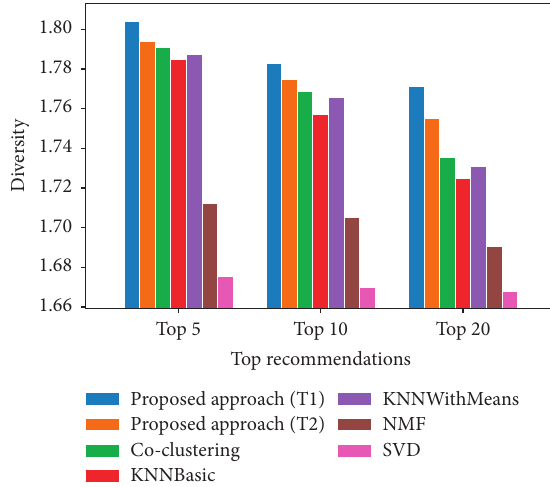
Figure 7: Diversity at ( k ) where k � 5, 10, and